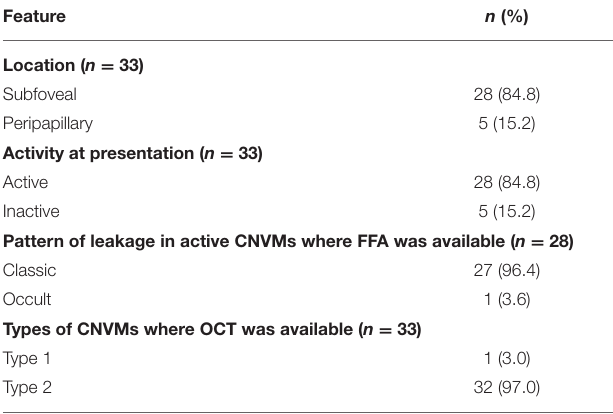
TABLE 1 | Demographic profile and ocular associations. TABLE 2 | Characteristics of